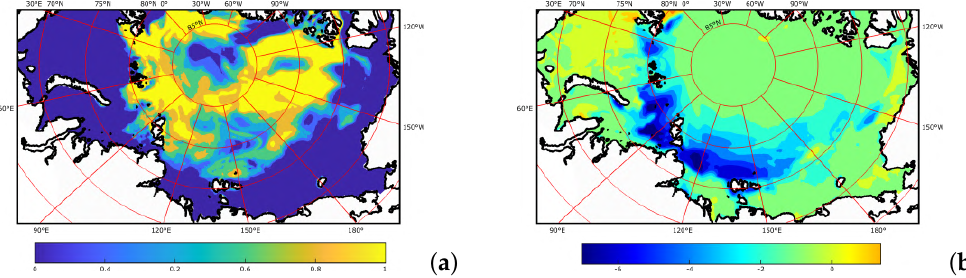
Figure 17. Sensitivity of ice state and SST to removal of ice drift from consideration. Difference (D1-A0) in simulated ice thickness ( a ), (in m); SST ( b ), (in ◦ C) in